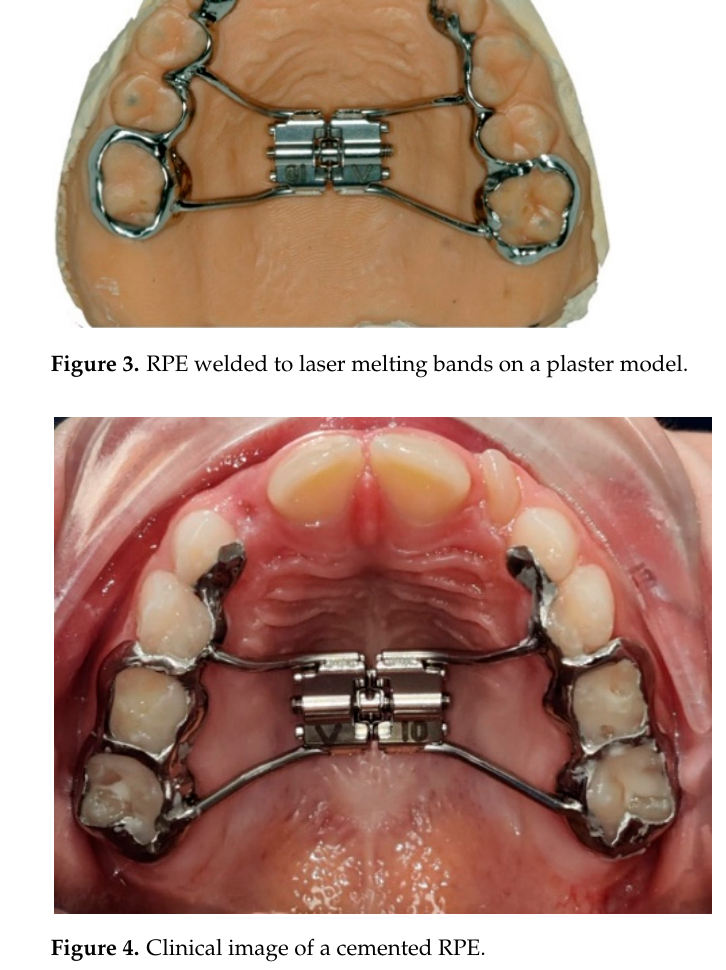
Figure 6. Three dimensional (3D) printed surgical guide for the placement of orthodontic minis- crews.